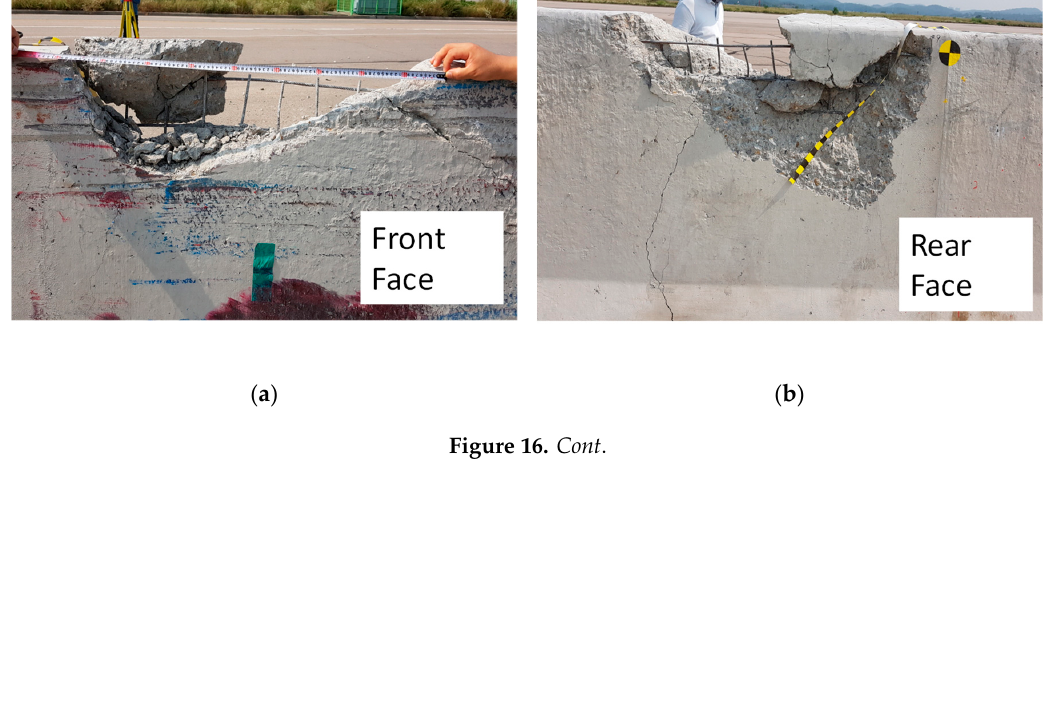
Figure 15. Lateral displacement along longitudinal direction of CMB-17S, measured with respect to several LVDTs.